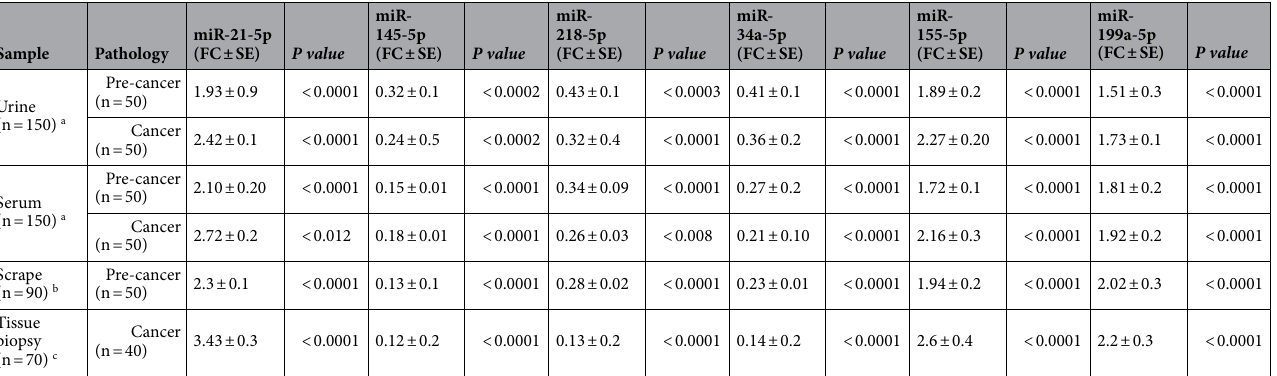
Table 2. Relative expression level of miRNAs in paired urine, serum, cervical scrapes, and tissue biopsies. FC fold change, SE standard error. a Including 50 urine and 50 serum samples from normal controls. b Including 40 cervical scrape from normal controls. c Including 30 paired adjacent non-malignant normal